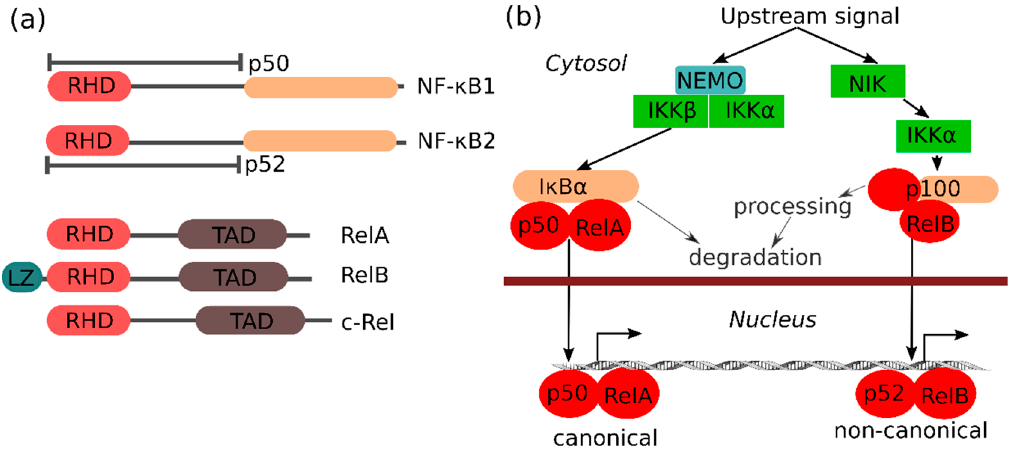
Figure 1. Structure and signaling of NF- κ B and NF- κ B-associated components. ( a ) Domain composition of class I and II NF- κ B family members. Rel homology domain (RHD), transactivating domain (TAD), leucine zipper (LZ), I κ B ankyrin repeat domain is colored in orange ( b ) A simple overview of the canonical and non-canonical NF- κ B signaling pathways. Kinases are presented in green, NF- κ B subunits in red, and I κ B proteins in orange. In both pathways, phosphorylation leads to the proteasomal removal of inhibitory domains (e.g., in case of p100) or proteins (in case of I κ B α ) that prevent the NF- κ B dimers from entering the nucleus to activate transcription. Alternative canonical NF- κ B activation pathways via IKK ε /TBK1 or IKK-independent pathways are not